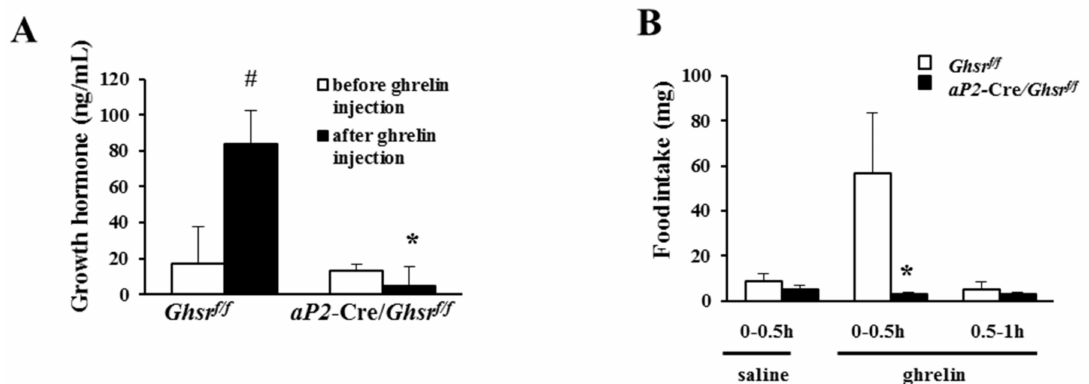
Figure 2. aP2 -Cre/ Ghsr f/f mice show impaired growth hormone secretion and acute ghrelin-mediated food intake. ( A ) Growth hormone level of the mice before and after i.p. injection of 20 µ g ghrelin. n = 6, # p < 0.05, before and after ghrelin injection. * p < 0.05, Ghsr f/f vs. aP2 -Cre/ Ghsr f/f ; ( B ) acute food intake of the mice after i.p. injection of either saline or 20 µ g ghrelin. n = 9–10. * p < 0.05, Ghsr f/f vs. aP2 -Cre/ Ghsr f/f . The results were represented as mean ± S.E.M. Two-tailed Student’s t -test or repeated measures analysis of variance (ANOVA) was used for statistical